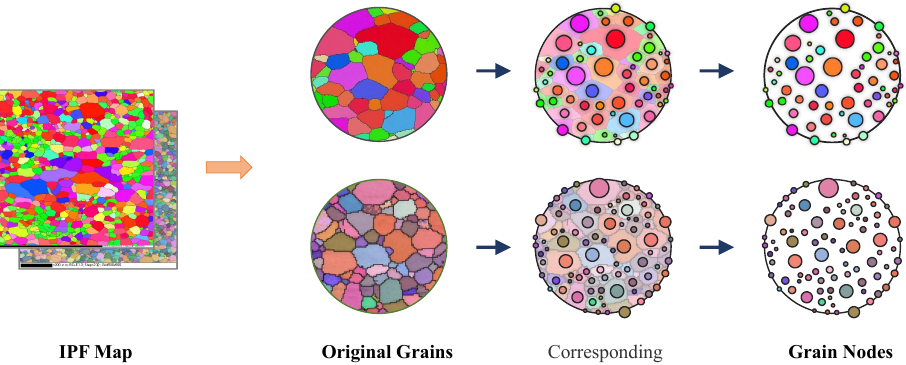
Figure 2. Grain node construction process. Each grain in the IPF map corresponds to each grain node in the graph. Each node stores the features of the grain.